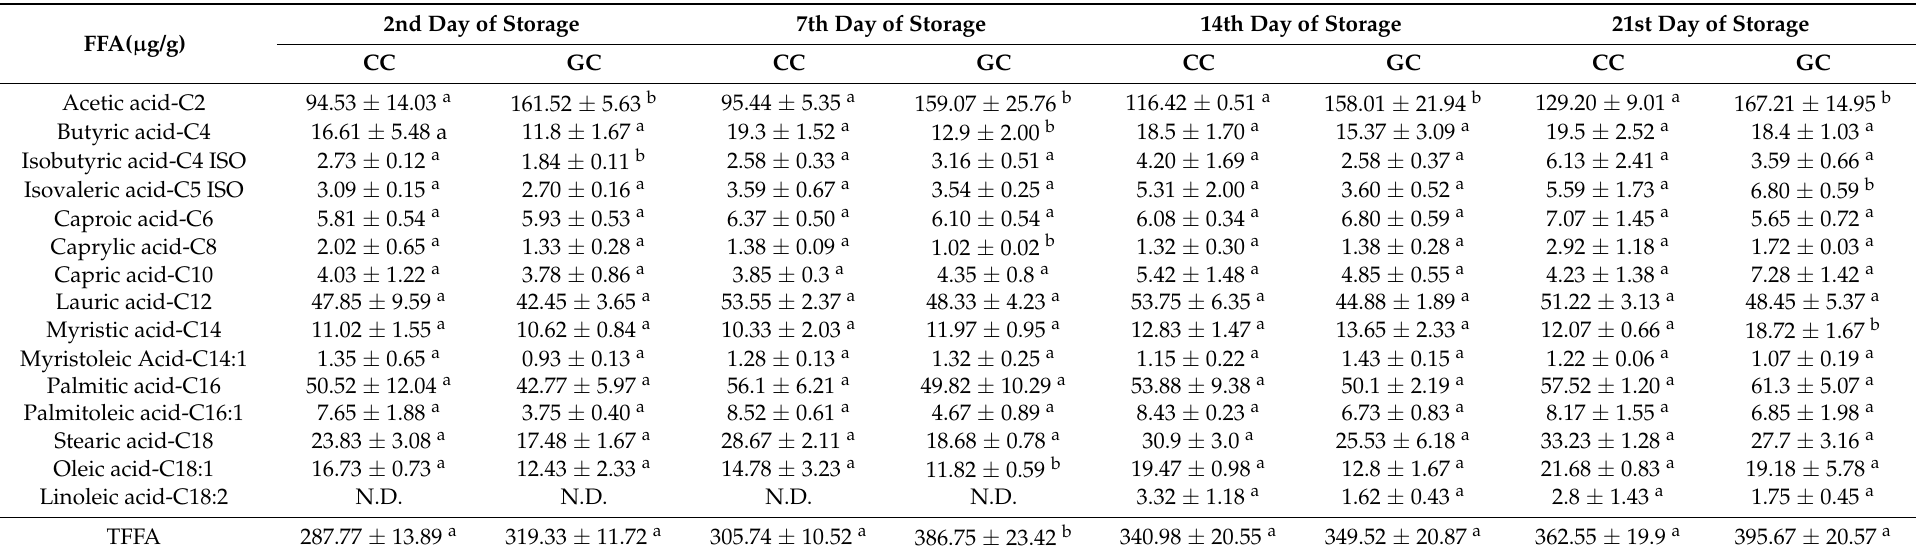
GC: cheeses fortified with β -glucan; CC: control cheeses (without fortification with β -glucan). N.D.: Not Detected. Means of three replicates ± standard error. For each parameter in the same row and time, different letters indicate statistically significant differences between the cheeses ( p <